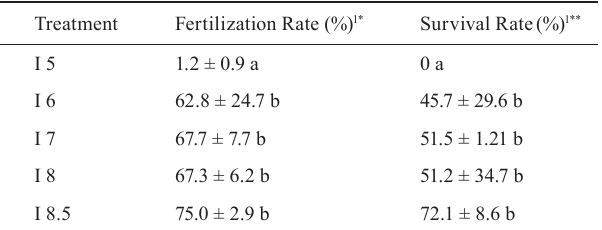
Fig. 1. Experimental design elaborated for the incubation and larviculture stages of Prochilodus lineatus . 1 In the treatments tested in the larviculture, the first number represents the incubation pH history and the second the pH in which the larviculture took place. The larviculture treatments will be described in this fashion throughout the text. * Treatment not accomplished due to an almost total mortality in the incubation stage.